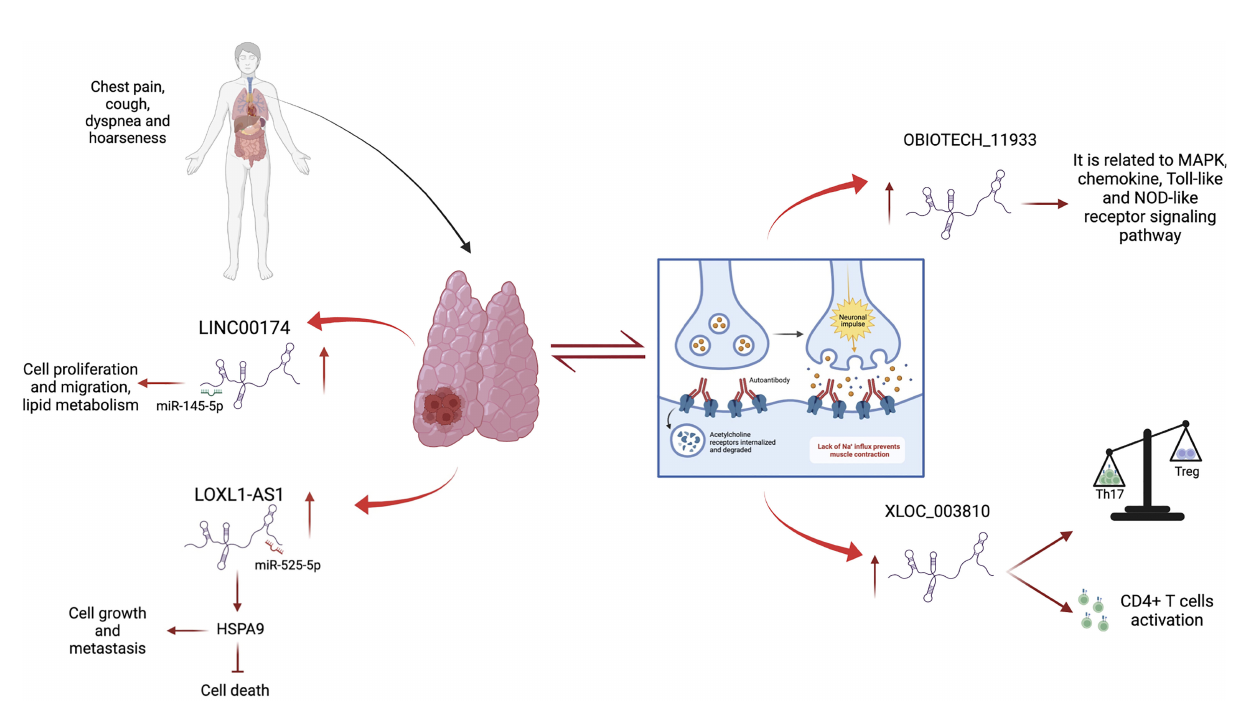
FIGURE 1 | Contribution of lncRNAs in TETs and MG. LINC00174 and LOXL1-AS1 are up-regulated in thymoma and thymic carcinoma, where they act as sponges of miR-145-5p and miR-525-5p, respectively, promoting cell growth, metastasis, migration, and lipid metabolism and inhibiting cell death. LncRNAs are deregulated in MG, an autoimmune disease strongly associated with thymoma. Oebiotech_1193 and XLOC_003810 are overexpressed in MG patients and are involved in in fl ammatory